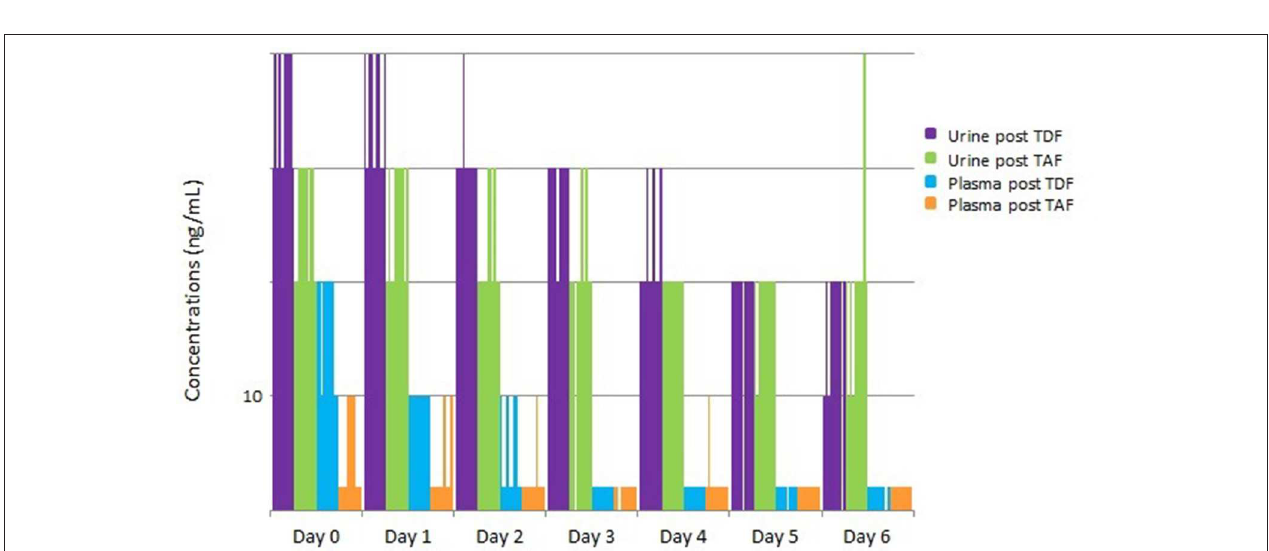
FIGURE 3 | Urine/Plasma TFV concentrations after a single dose of FTC/TAF in 10 HIV-subjects, with comparison to historical cohort of subjects given a single dose of FTC/TDF. TFV, tenofovir; FTC/TAF, emtricitabine/tenofovir alafenamide; HIV–, Human Immunodeficiency Virus-Negative; FTC/TDF: emtricitabine/tenofovir disoproxil fumarate; TDF, tenofovir disoproxil fumarate; TAF, tenofovir alafenamide; ng/mL, nanograms per